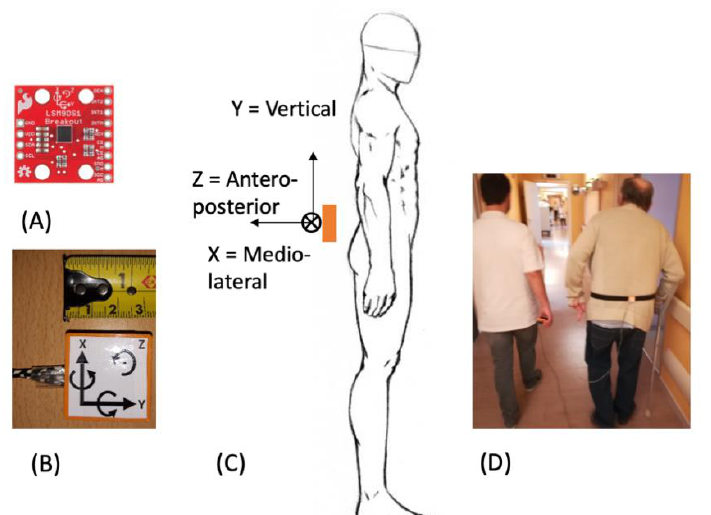
Figure 1. ( A ) The LSM9DS1 sensor (SparkFun) used to record acceleration and angular speed. ( B ) LSM9DS1 sensor within the DYSKIMOT system. Sensor’s cartesian frame is indicated. The curved arrows give rotation’s positive direction. ( C ) Schematic placement of a DYSKIMOT sensor on a patient. The sensor’s cartesian frame matches the walking directions. ( D ) A patient equipped with DYSKIMOT sensor (right) with one experimenter (R.G.) walking aside.